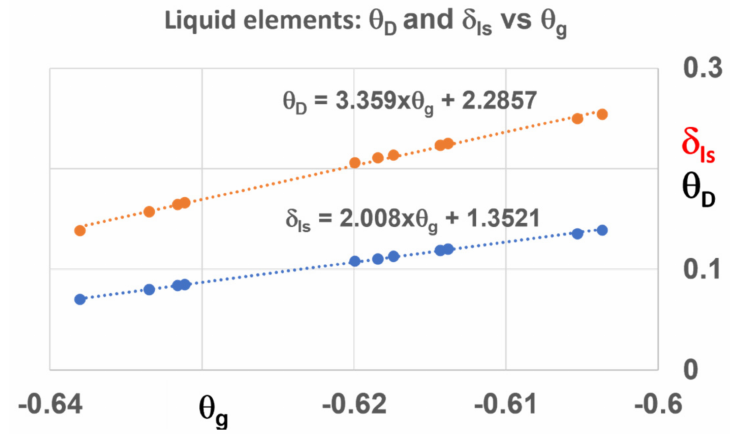
Figure 2. The Lindemann coefficient δ ls and the reduced homogeneous nucleation temperature − T m )/T m of liquid elements in the absence of overheated Phase 3 above T θ D = (T D reduced glass transition temperature θ g = (T g − T m )/T m .